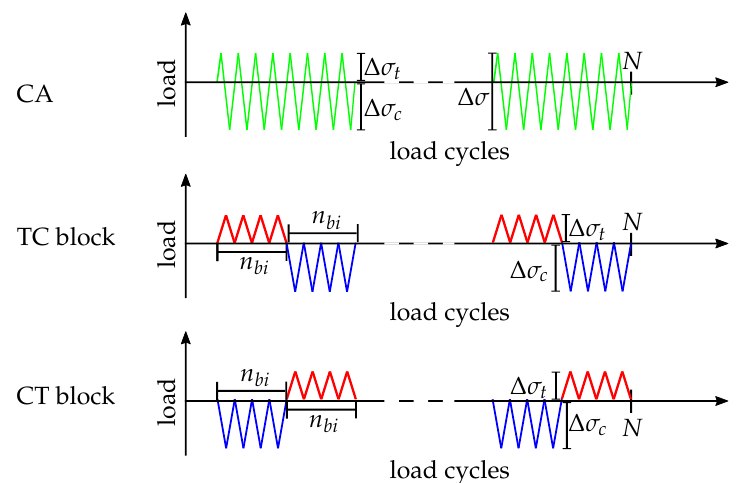
Figure 2. Schematic illustration of the loading sequences, constant amplitude loading (CA), tension-compression (TC) and compression-tension (CT) sequence. Block lengths within one experiment are equal for tension and compression blocks. Two different block lengths n bi are under investigation and tested in distinct